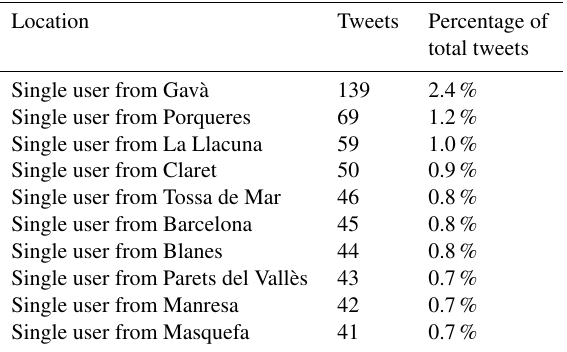
Table 2. Users with a higher share of the total number of tweets.